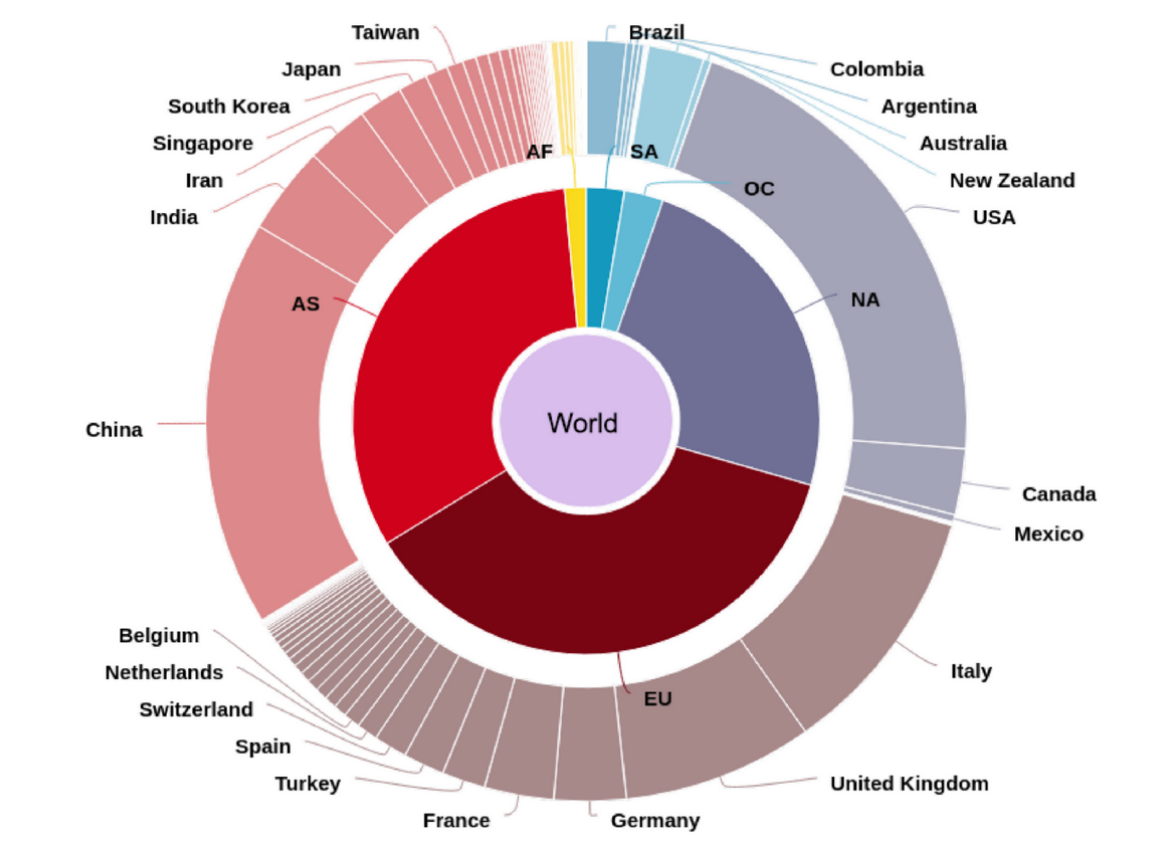
Figure 5. Country coverage of publications. The donut chart represents continents (AS: Asia; EU: Europe; NA: North America; SA: South America; OC: Oceania; AF: Africa) and countries contributing to the publication